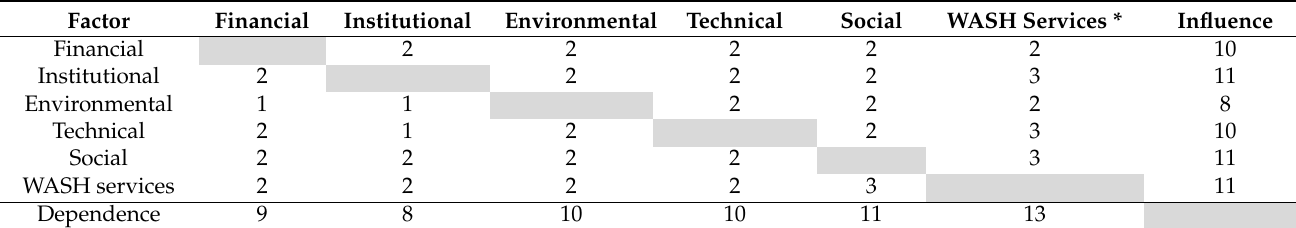
Table 1. The cross-impact matrix. The influencing factors are shown in the first column on the left and the affected factors are shown in the first row.